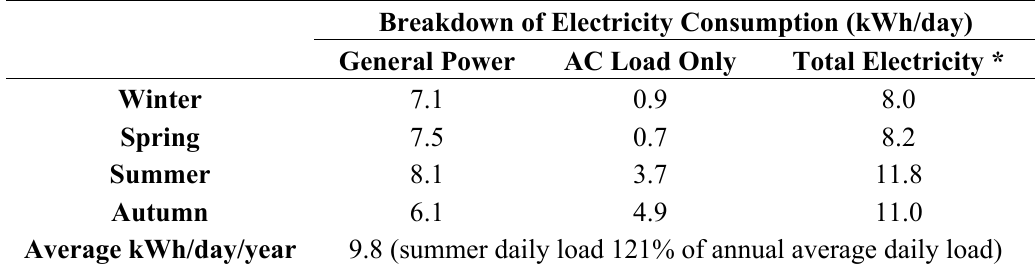
Table 5. Seasonal household electricity consumption